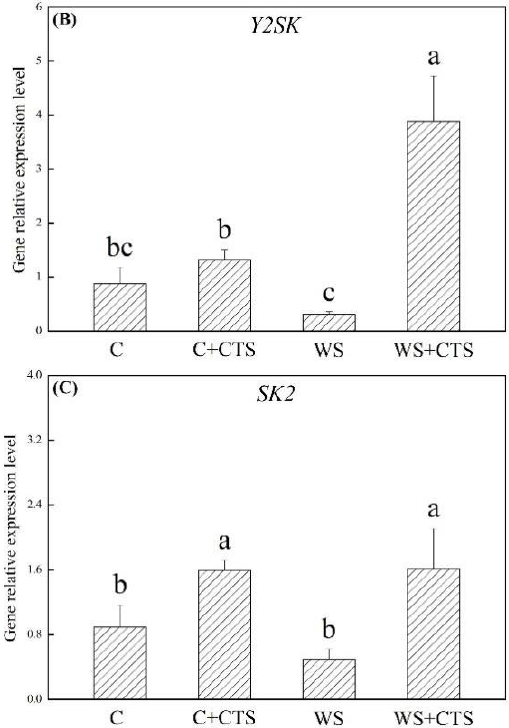
Figure 7. Seeds priming with chitosan affected genes expression levels of ( A ) Y2K , ( B ) Y2SK , and ( C ) SK2 encoding different types of dehydrins in seedlings after 7 days of germination under water stress. Vertical bars above columns indicate ± SE of mean, and different letters above columns indicate significant difference ( p < 0.05). C, control (seeds pretreated with H 2 O germinated under normal condition); C+CTS, control + CTS (seeds pretreated with CTS germinated under normal condition); WS, water stress (seeds pretreated with H 2 O germinated under water stress condition); WS+CTS, water stress + CTS (seeds pretreated with CTS germinated under water stress condition).